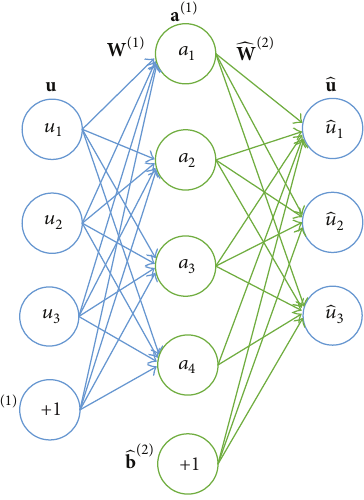
Figure 6: The single layer